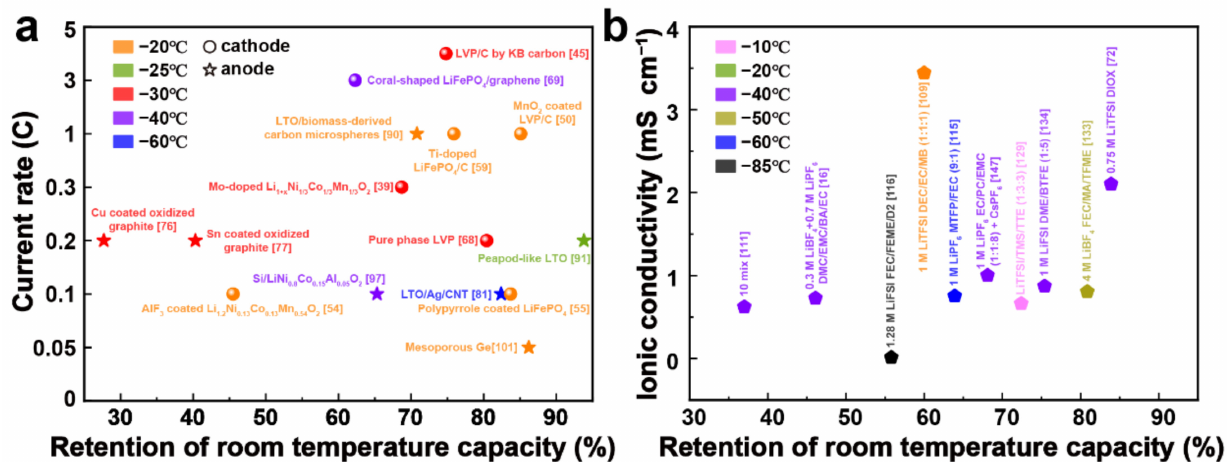
Figure 9. Notable research progresses in low-temperature LIBs: ( a ) electrodes; ( b )